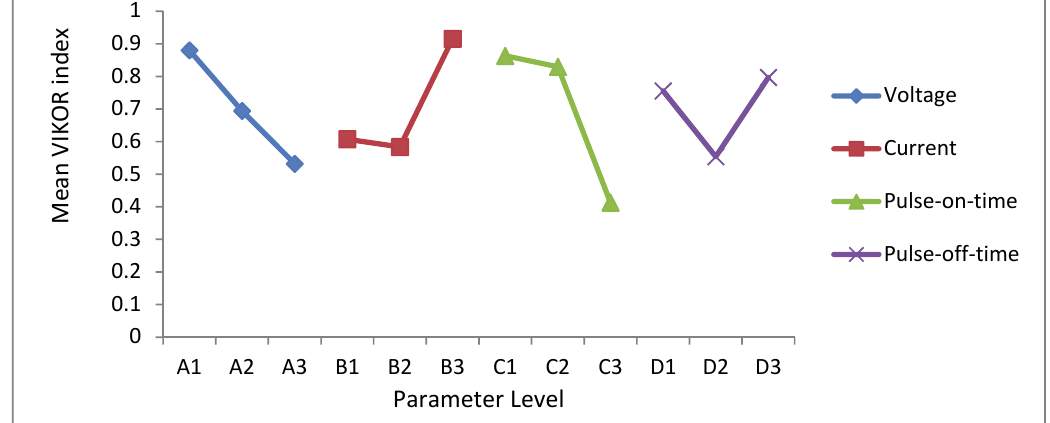
Fig. 6. Response graph of VIKOR index